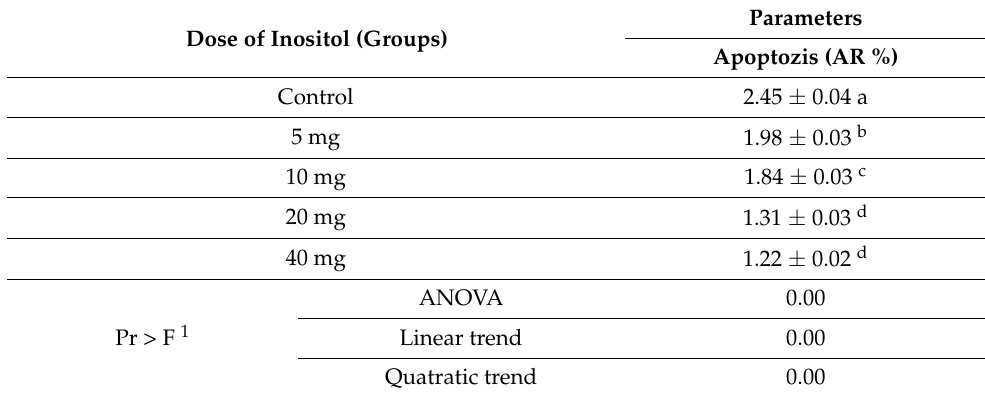
Table 4. Analysis of S. triostegus apoptosis after thawing using ELISA (mean ± SE; n = 7). Dose of Inositol